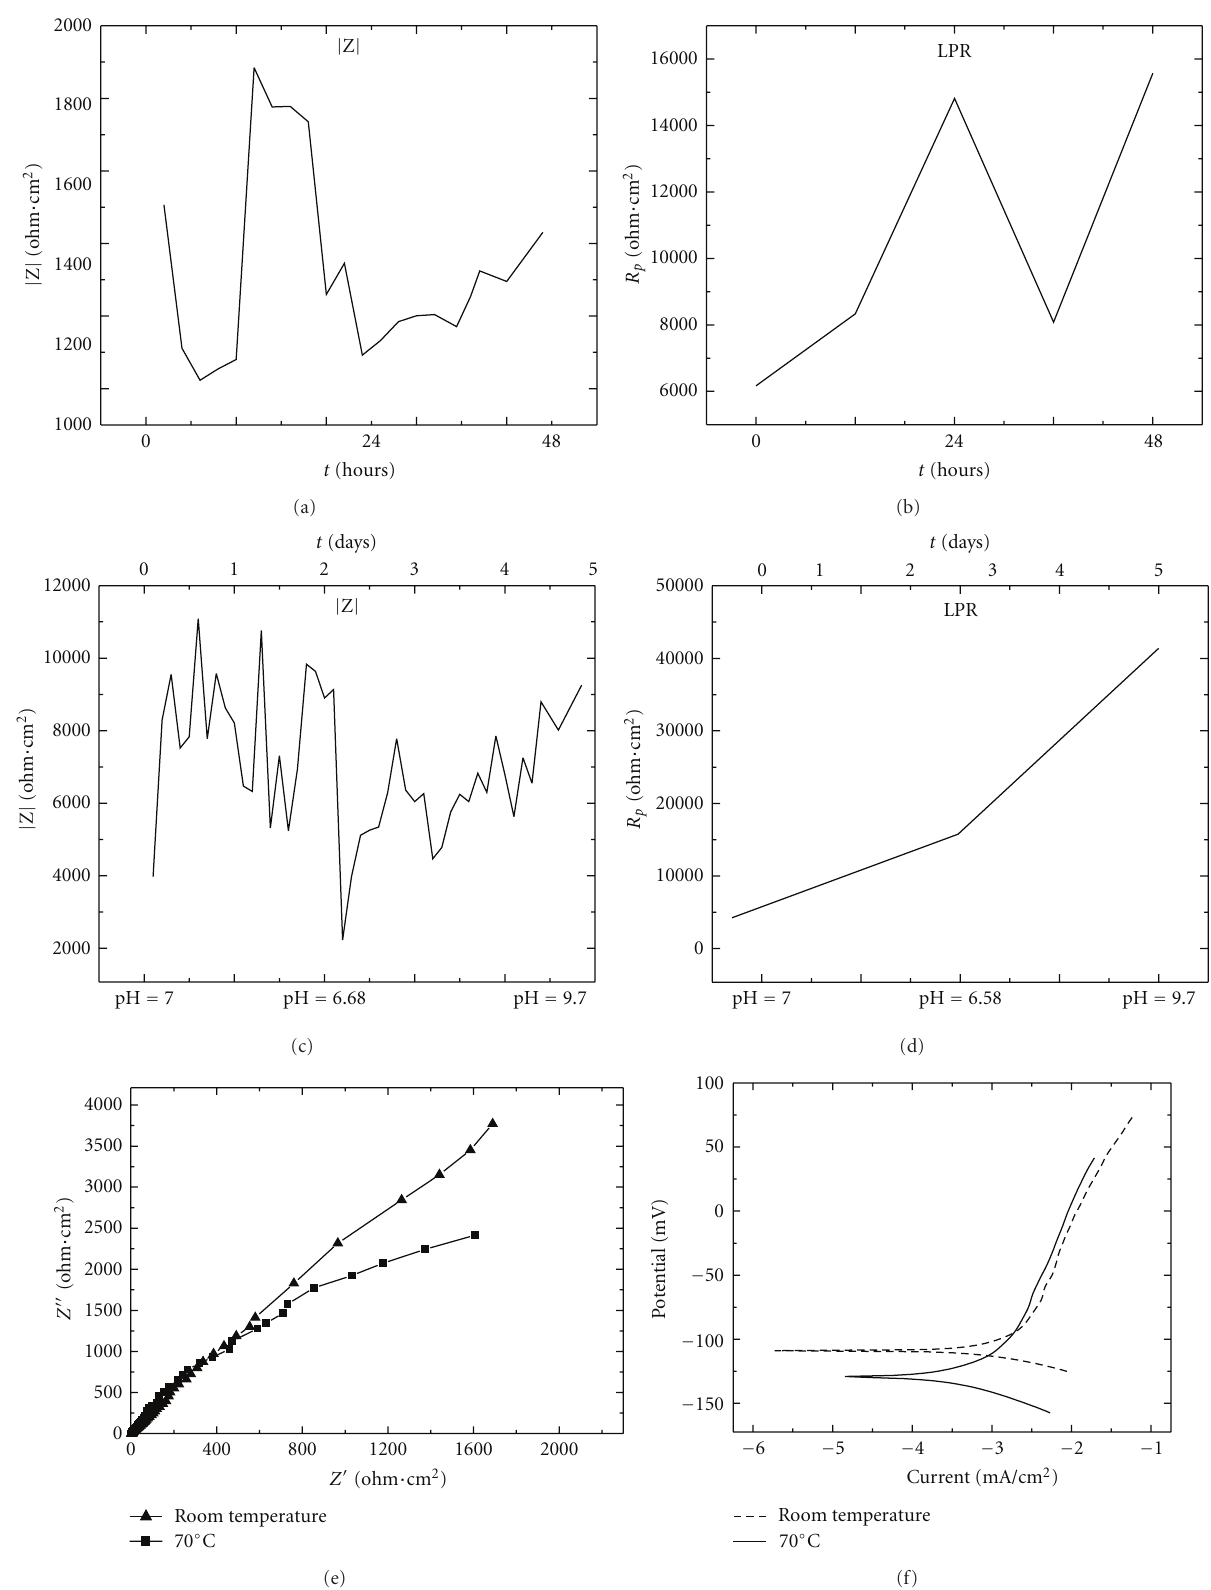
Figure 5: Electrochemical tests plots in the pH 7 solution, (a) | Z | at room temperature for 48 hours, (b) R p at room temperature for 48 hours, (c) | Z | at 70 ◦ C for 5 days, (d) R p at 70 ◦ C for 48 hours, (e) EIS Nyquist plot at room temperature and 70 ◦ C, and (f) polarization curves at room temperature and 70 ◦